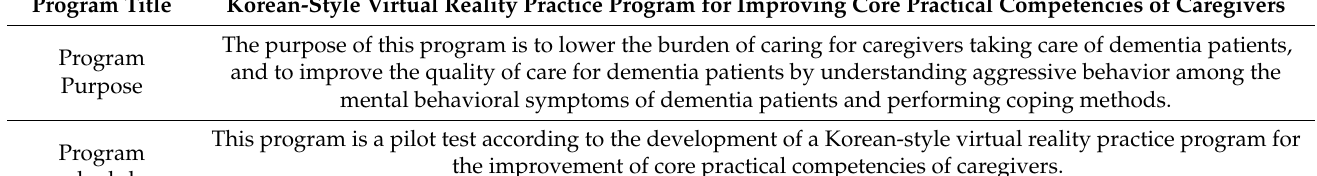
Table 4. Virtual reality practice program for improving core practical competencies of